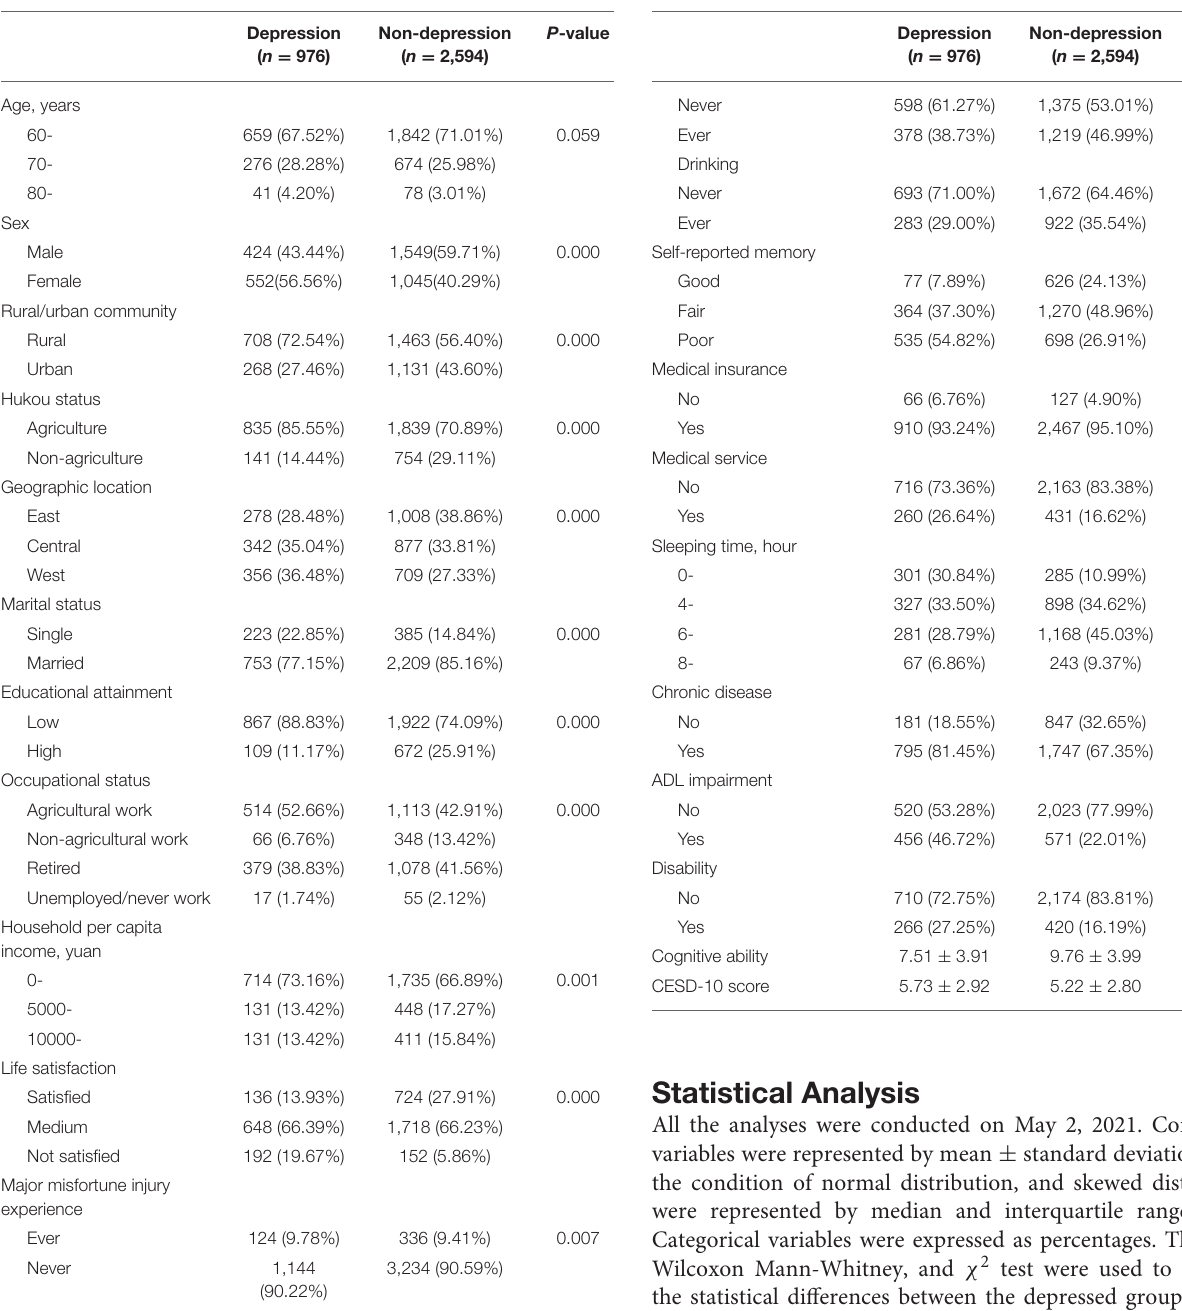
TABLE 1 | Characteristics of the study population in 2011.